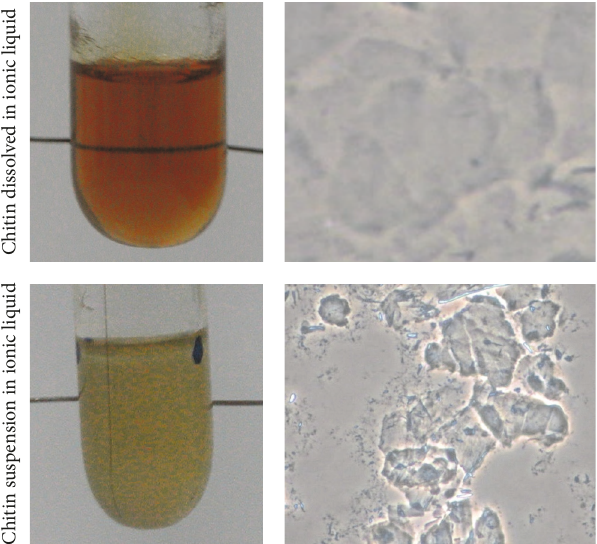
Figure 1: Dissolution of chitin in ionic liquid has been assessed visually and under light